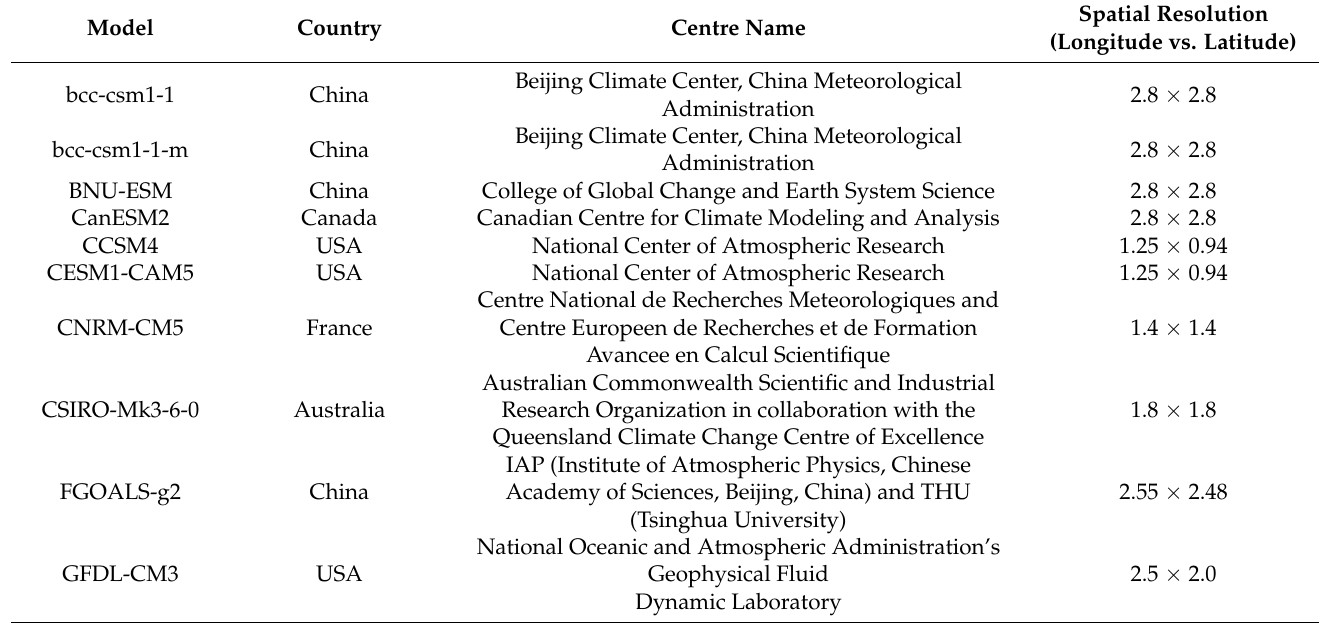
Table 2. Global Climate Models (GCM) models used in this